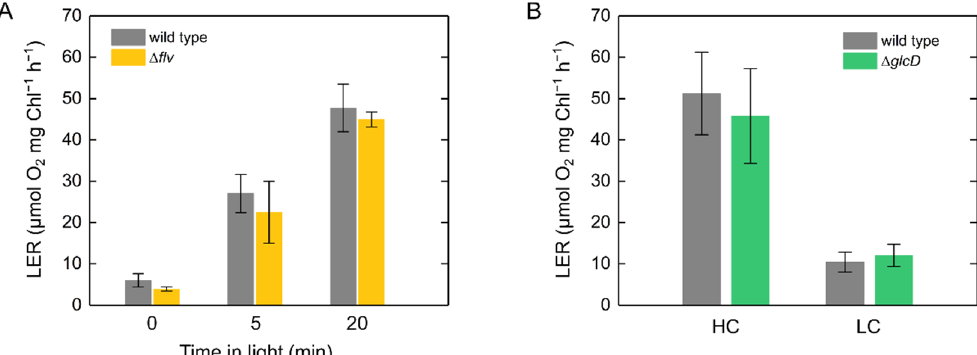
Figure 6. Light-enhanced respiration (LER) in wild type (grey bars) and the mutants of Synechocystis sp. PCC 6803 deficient in components related to alternative electron transport pathways. ( A ) LER in the mutant that lacks flavodiiron proteins 1, 3, and 4 ( ∆ flv , yellow bars). ( B ) LER in the mutant deficient in glycolate dehydrogenase 1 and 2 ( ∆ glcD , green bars). In “HC (high CO 2 )”, cyanobacterial cells adapted to the darkness for 24 h (10 µg Chl mL − 1 ) were illuminated with red actinic light (190 µmol photons m − 2 s − 1 ) for 20 min, as in the LER measurements in the other strains. The “LC (low CO 2 )” indicates the condition where available CO 2 is limited, which was prepared by a long-term (1–2 h) illumination without adding NaHCO 3 to the oxygen electrode chamber (Shimakawa et al., 2015). The actinic light was turned off at the steady state under CO 2 limitation, and then LER was measured. Data are shown as the mean with the standard deviation ( n = 4, biological replicates).